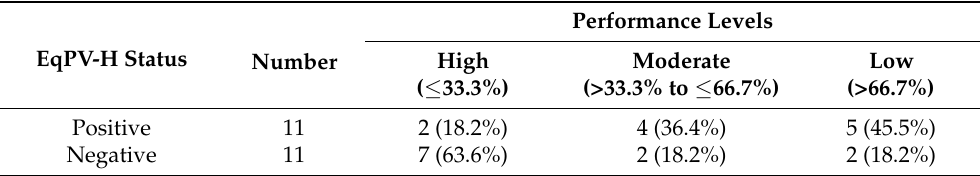
Table 3. Performance levels of equine parvovirus-hepatitis (EqPV-H)-positive and EqPV-H-negative thoroughbred racehorses in South Korea ( n =